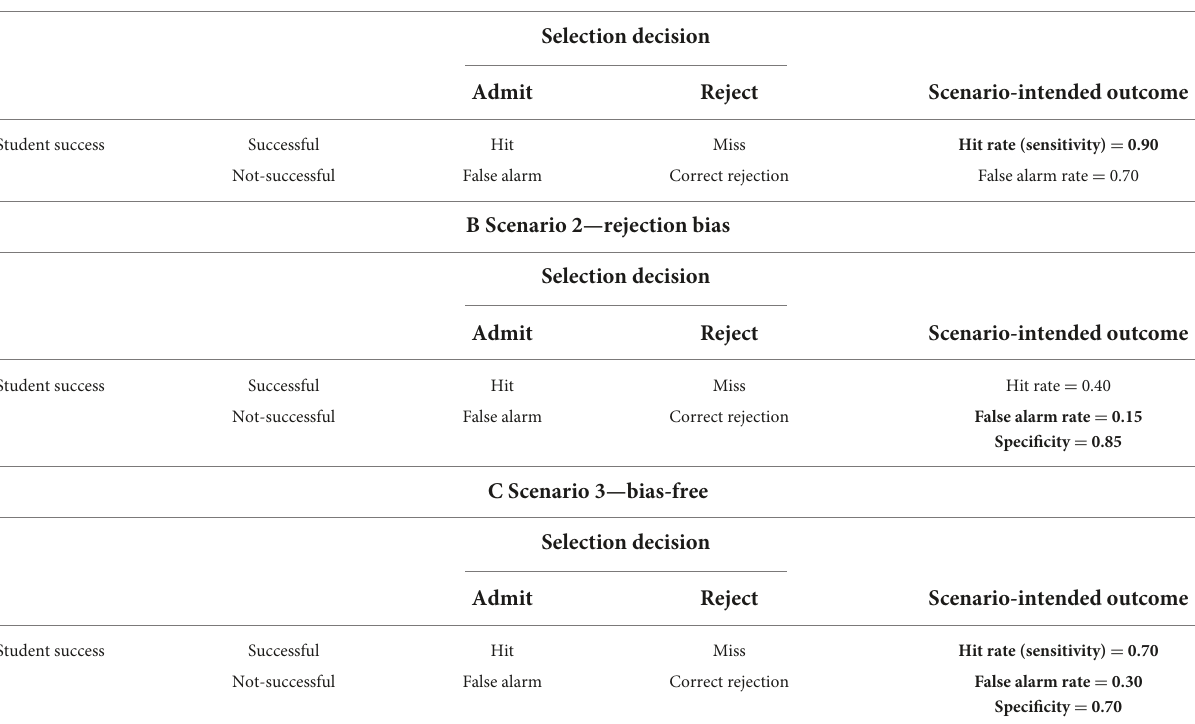
TABLE 2 Three possible selection